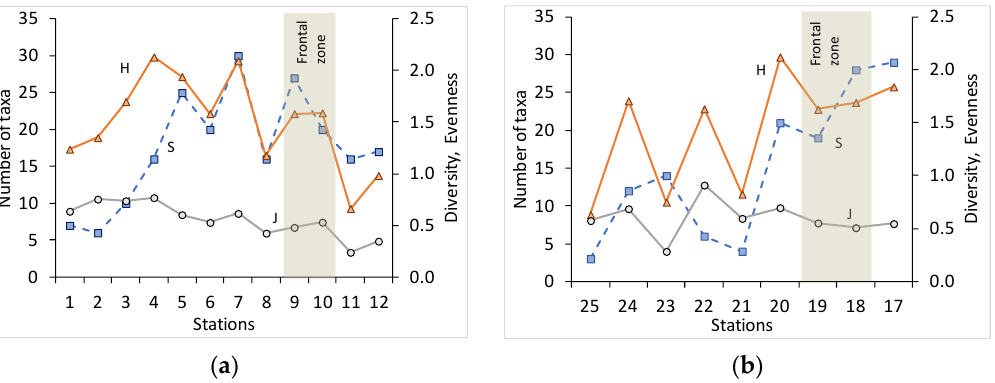
Diversity. At stage one, the richness and diversity generally increase eastward from the Barents Sea, reaching the peak in the eastern part of the MZ (station seven), then dropping in the EZ. Two weeks later, at stage two, the opposite pattern was observed, with the highest diversity in the EZ (Figure 7).